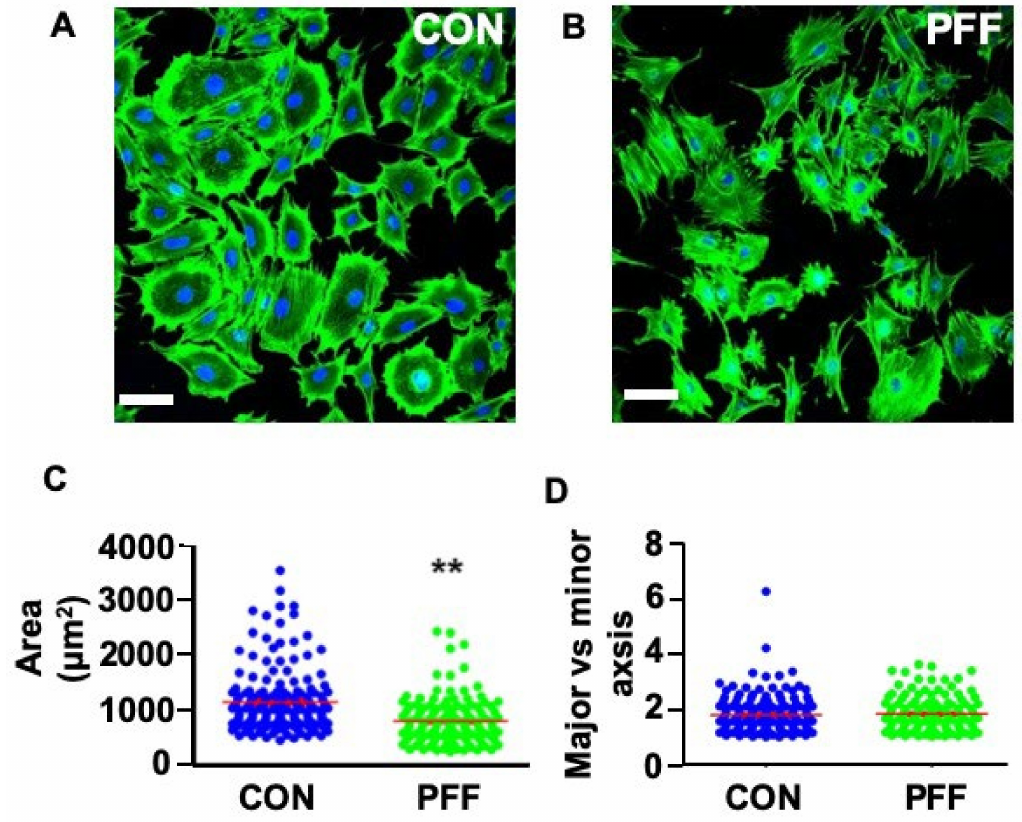
Figure 2. E ff ect of 1 h PFF on the spreading of MC3T3-E1 osteoblasts. ( A ) 2D image of fixed static control cells stained with phalloidin for F-actin (green) and DAPI for the nuclei (blue). ( B ) 2D image of 1 h PFF-treated cells stained with phalloidin and DAPI. ( C ) Cell spreading area measurement and analysis. ( D ) Cell shape / elongation measurement and analysis (cell spreading length vs. cell spreading width). N = 175 (control) and 165 (PFF) cells from 4 separate glass slides. CON, control; PFF, pulsating fluid flow. ** p < 0.01. ns, not significant. Bar = 100 µ